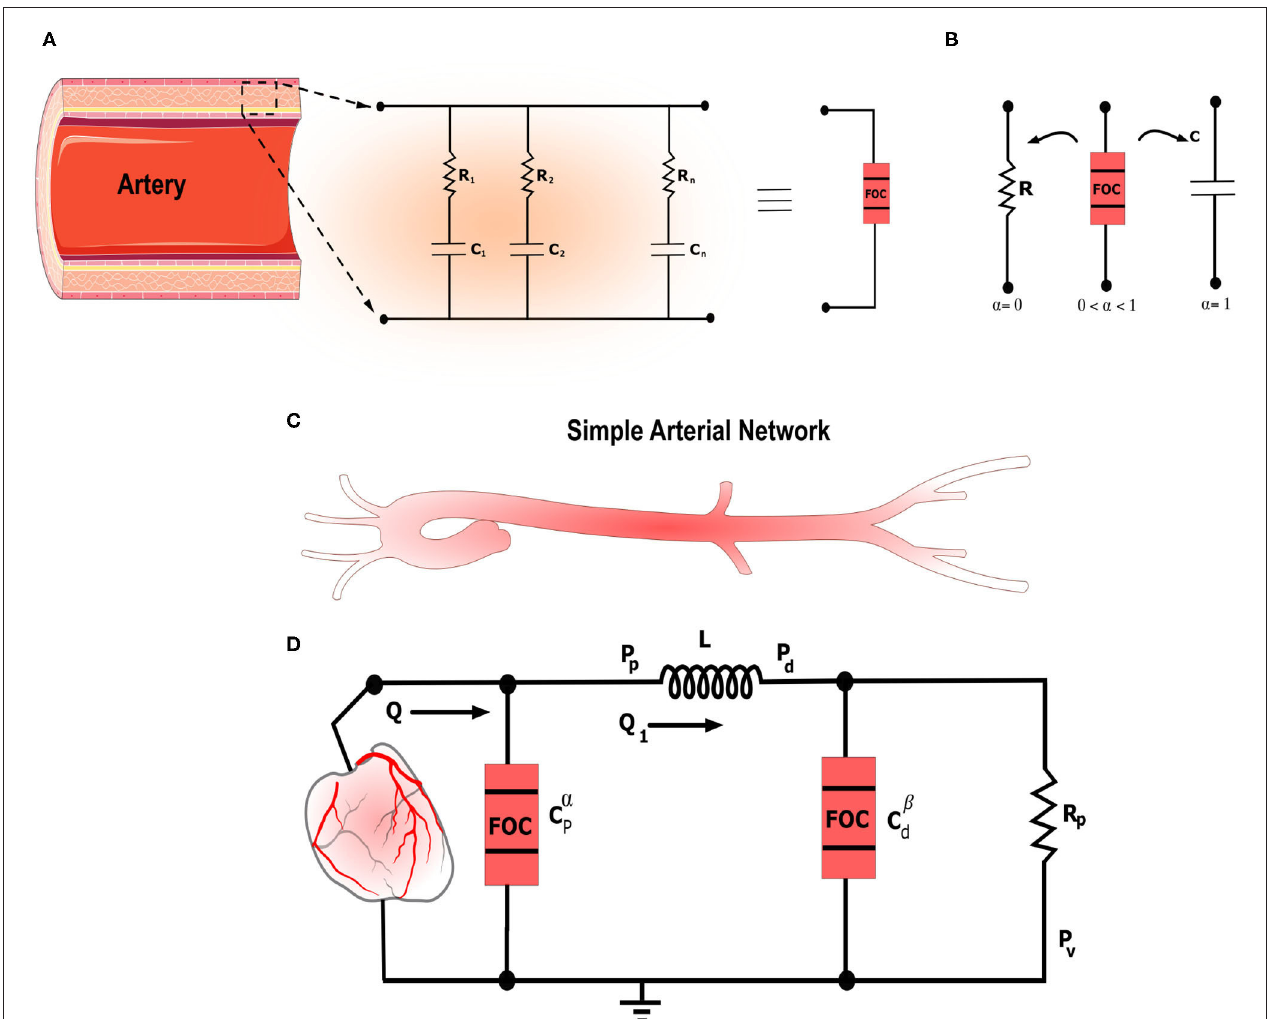
FIGURE 1 | The figure illustrates the general framework for fractional-order modeling of the arterial system in a schematic manner. (A) Schematic illustrating the artery along with the equivalent RC tree equivalent circuit of the fractional-order capacitor. (B) Electrical symbols of the standard resistor and capacitor and the fractional-order capacitor. 0 < α < 1 represents the fractional differentiation order. For α = 0 and α = 1 the fractional-order capacitor is equivalent to the standard resistor and capacitor, respectively. (C) Schematic that shows simplified left ventricle-aortic-arteries sub-domains. (D) Electrical analog of the proposed fractional-order modified Windkessel (F-MWK)